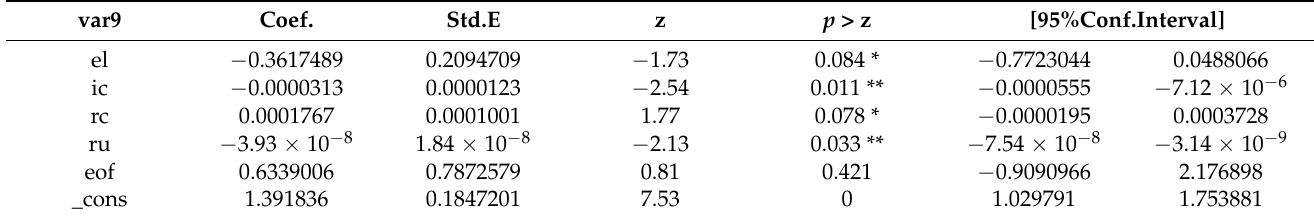
Figure 4. Malmquist indices of 16 cities in Anhui Province from 2015 to 2020. Table 5. Tobit regression